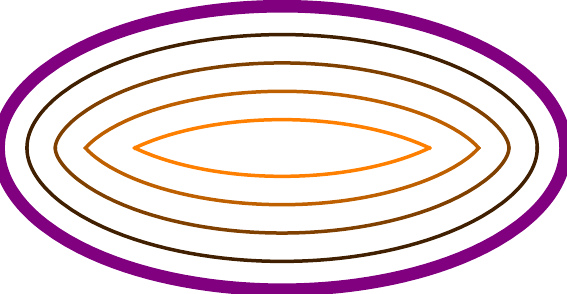
Figure 17. Tsunami evolution (with constant v ts ) for an ellipse drawn with purple. The wavefront is colored lighter as we go to later time. The wavefront develops a swallowtail singularity at a (cid:12)nite time, which complicates the numerical solution of the di(cid:11)erential equation (6.4).